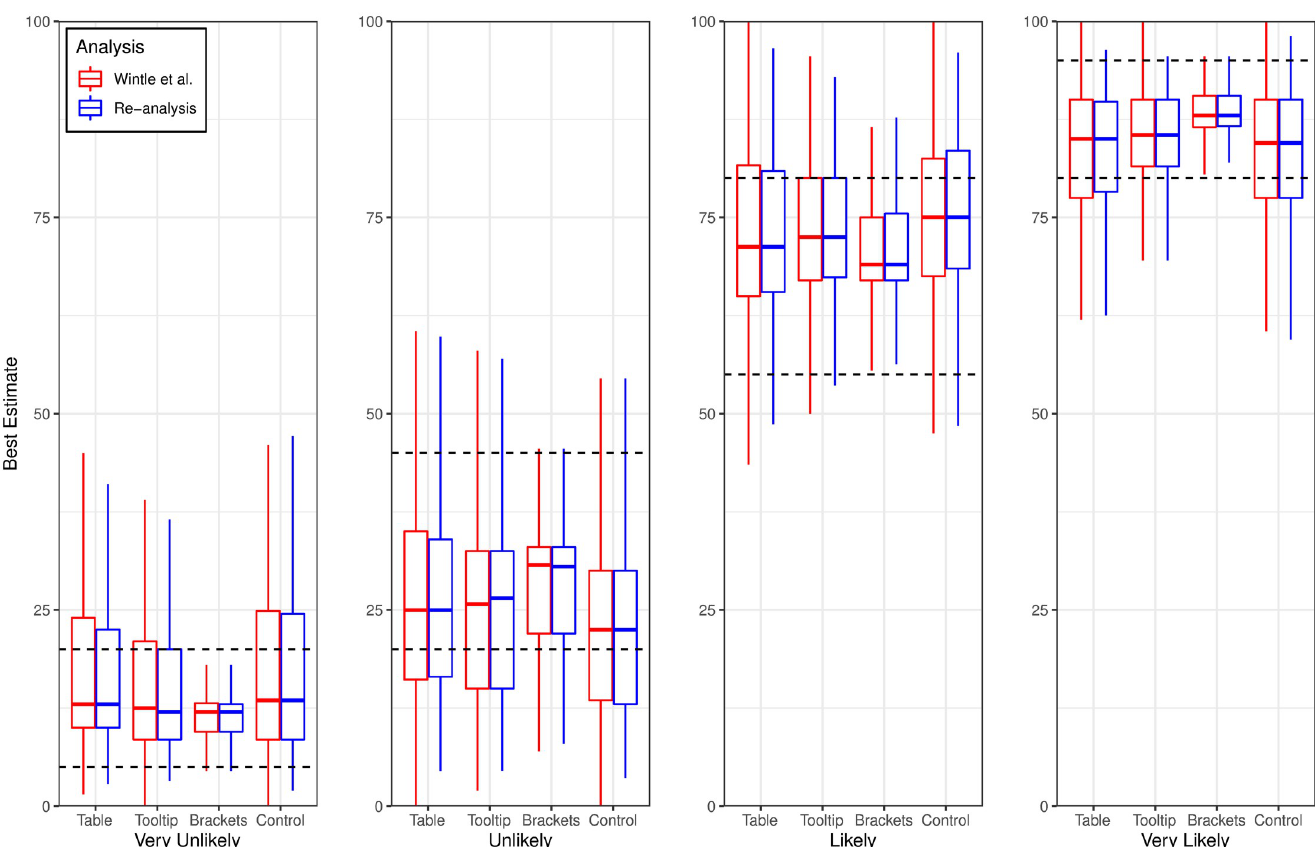
Fig 2. Box plots showing the median percentage of participant’s best estimates that agree with ICD 203 (the stipulated ranges are demarcated by the dashed lines). Results are plotted as a function of presentation format (i.e., Table, Tooltip, Brackets, and Control conditions), probability term (i.e., Very Unlikely, Unlikely, Likely, and Very Likely), and analysis type ([1] in red and our re-analysis in blue).